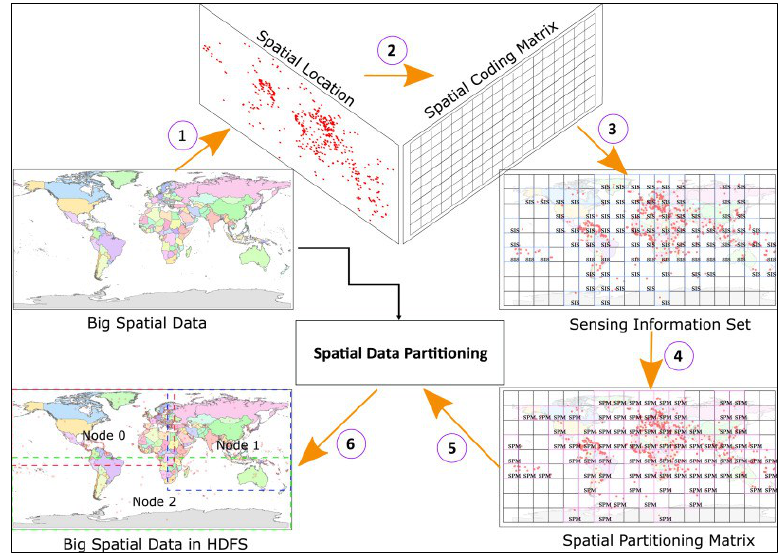
Figure 4. The algorithm of spatial partitioning based on SCA (Spatial Coding-based Approach) [22].